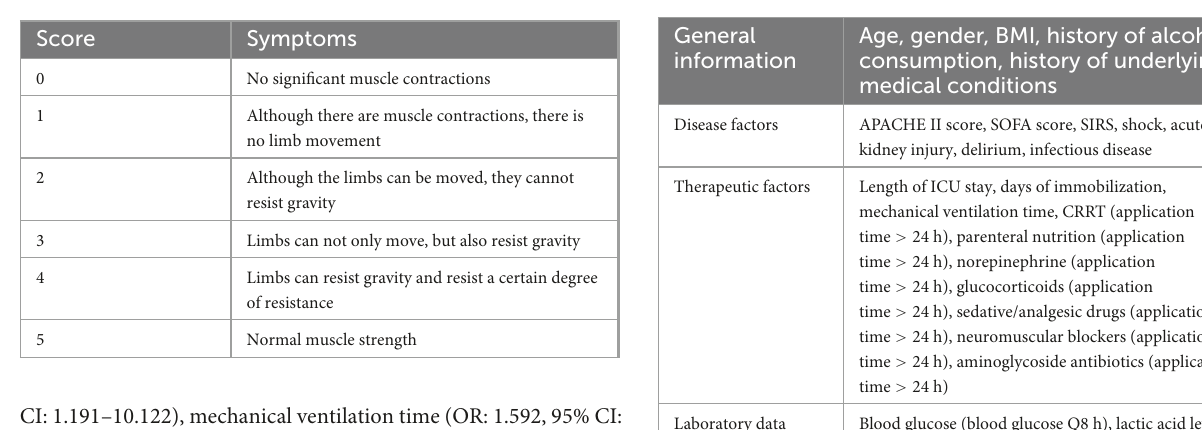
TABLE 3 Bedside muscle strength assessment criteria. TABLE 4 Patients clinical